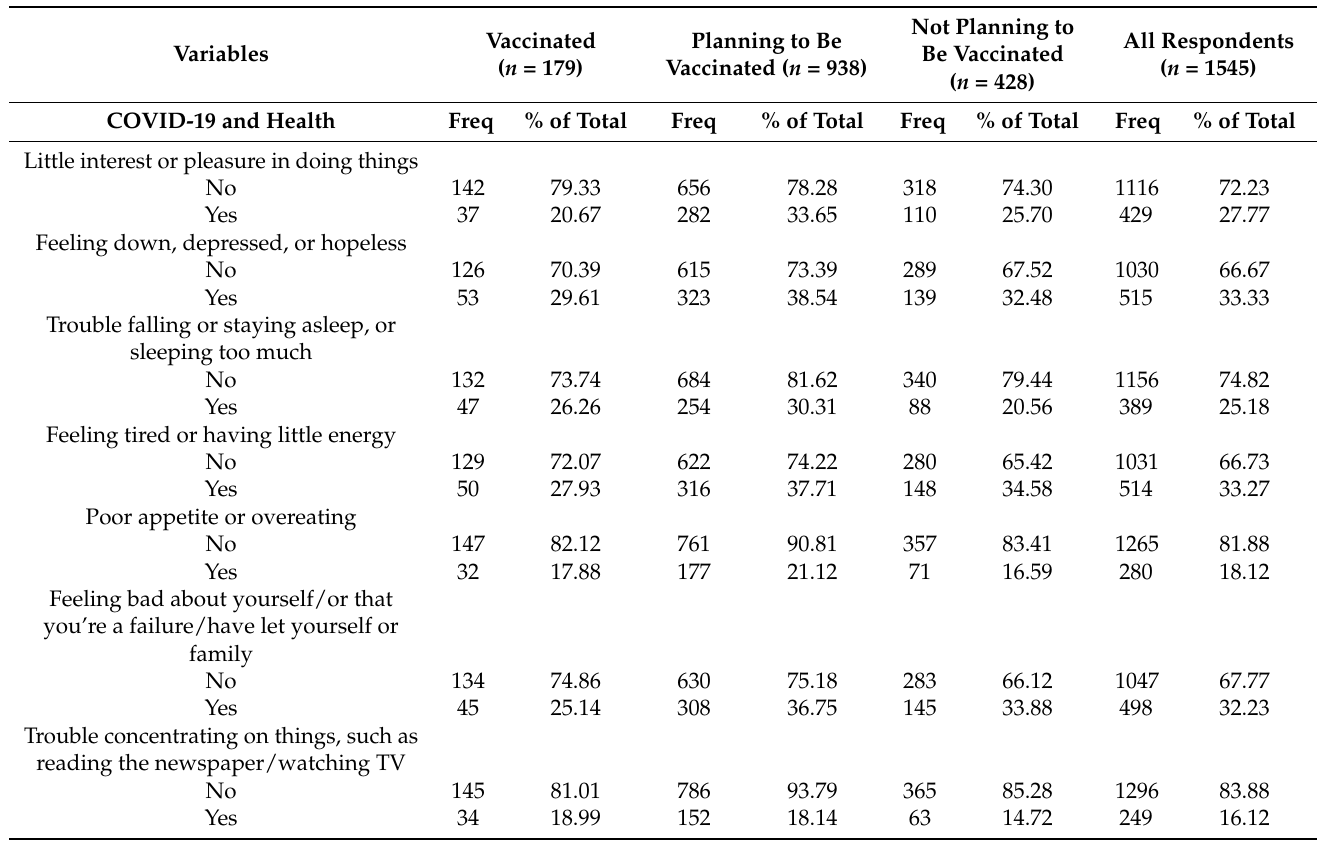
Table 3. Respondents’ Experiences of Stress Across Their Vaccination